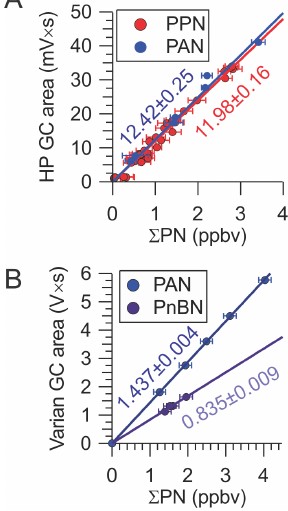
Figure 5. Sample calibration plots of PAN-GC peak area against (cid:54) PN mixing ratio. (a) PAN and PPN as observed the HP PAN-GC. (b) PAN and PnBN as observed by the Varian